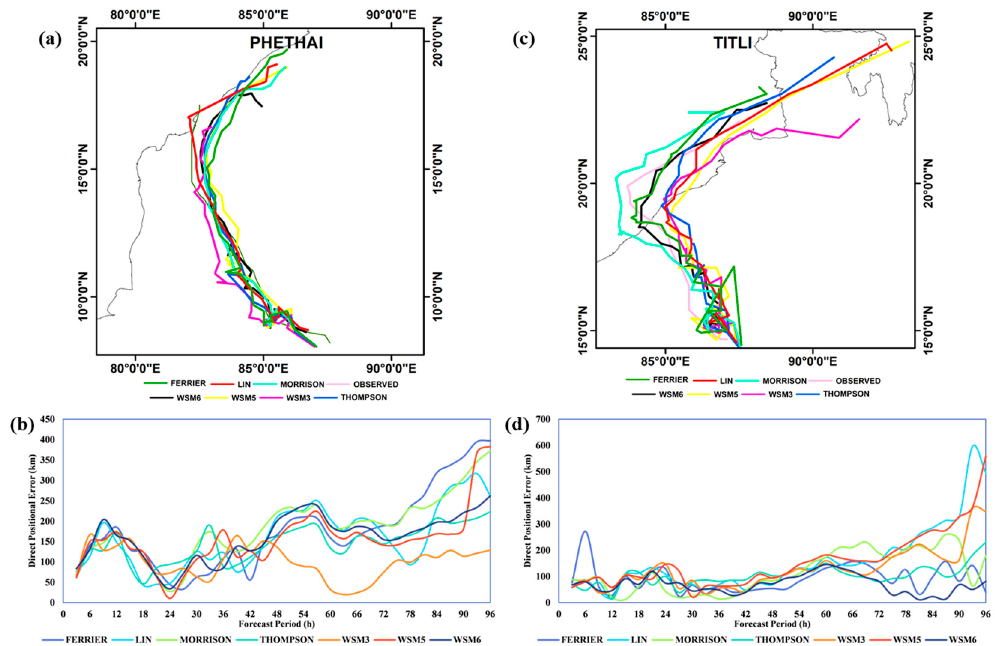
Figure 3. Observed and predicted tracks of tropical cyclones initiated at deep depression stage along with DPE ( a ) track of Phethai Cyclone, ( b ) DPE of Phethai Cyclone, ( c ) track of Titli Cyclone, ( d ) DPE of Titli Cyclone.